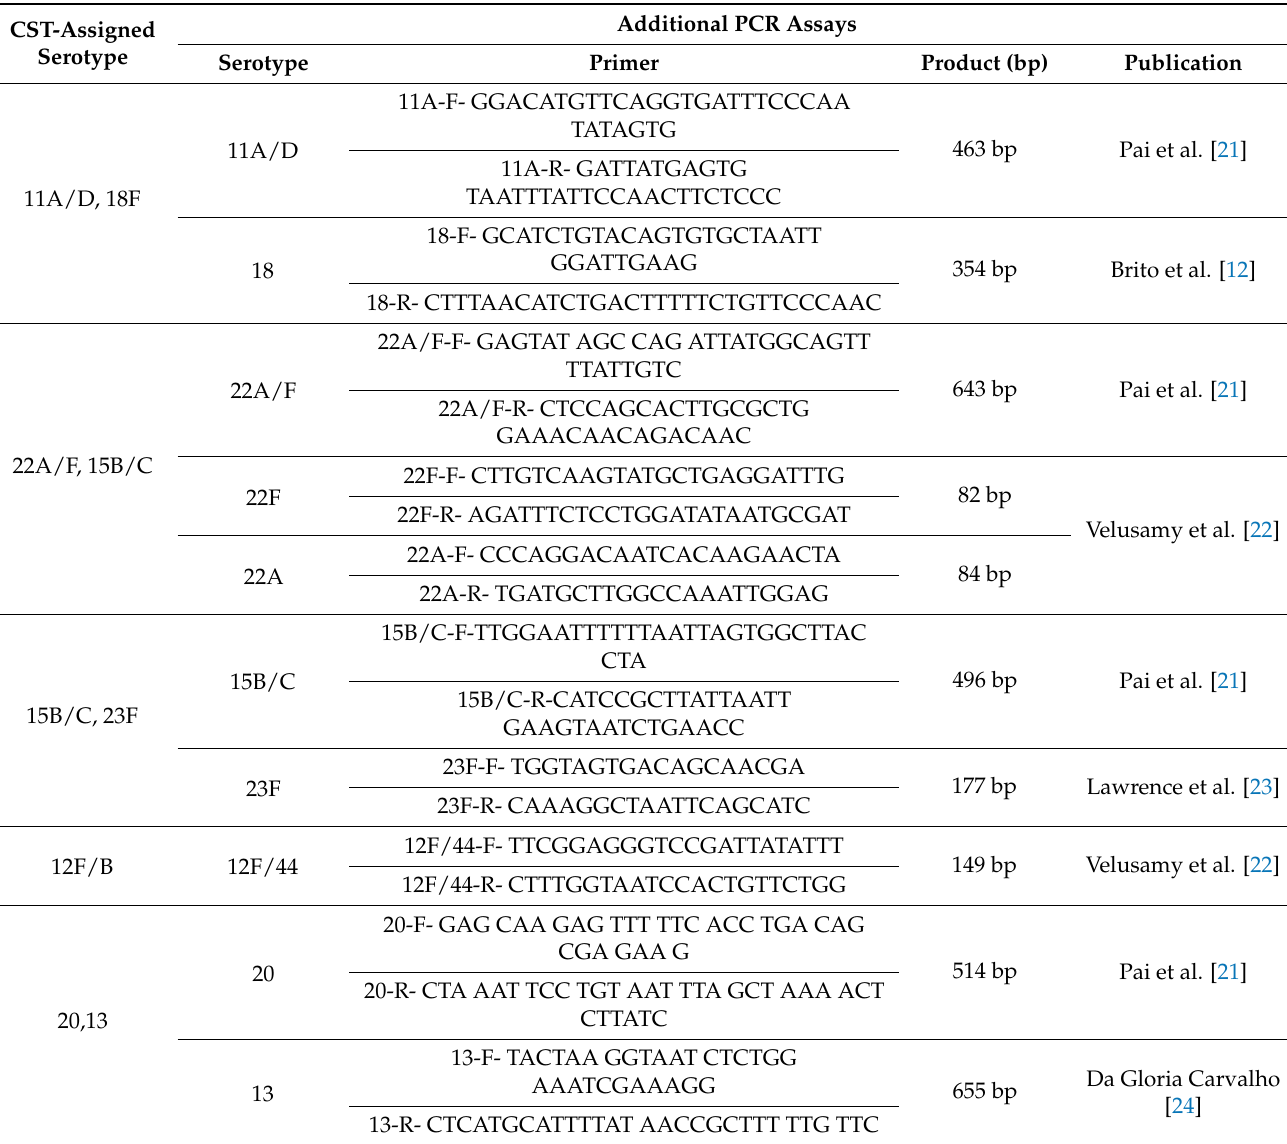
Table 2. PCR primers used for the additional single tube PCR assays for the identification of a single serotype among the specific group of serotypes assigned by